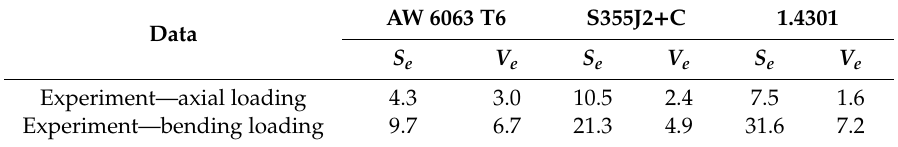
Table 8. Values of the standard error and the coe ffi cient of variation for the experimental results.